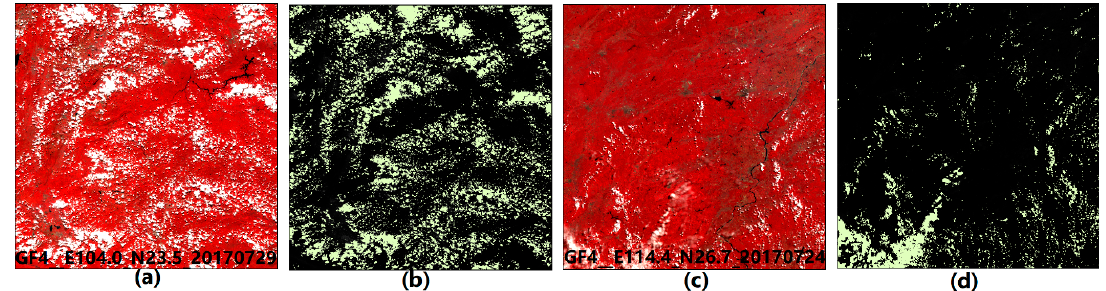
Figure 4. Cloud detection results for GF-4 PMS scenes over the land area. ( a ) The PMS data of the Yunnan Province region, China and ( c ) The PMS data of the central China region. ( b ) and ( d ) are the cloud detection results of ( a ) and ( c ), respectively. The white and black colors represent the cloudy region and the cloud-free region, respectively, of ( b ) and ( d ). The acquisition dates and the central longitudes and latitudes are presented in Table 2 .